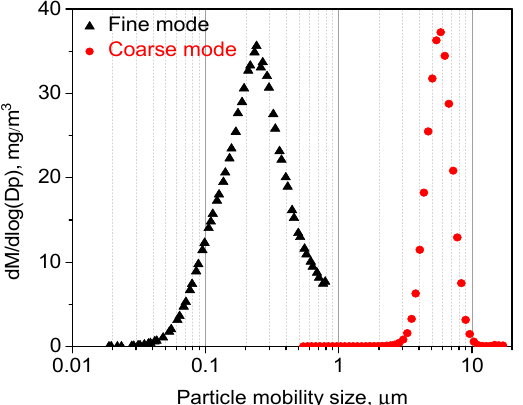
0.01 Figure 3. Particle size distribution of the coarse solid and the fine oil particles. Figure 3. Particle size distribution of the coarse solid and the fine oil